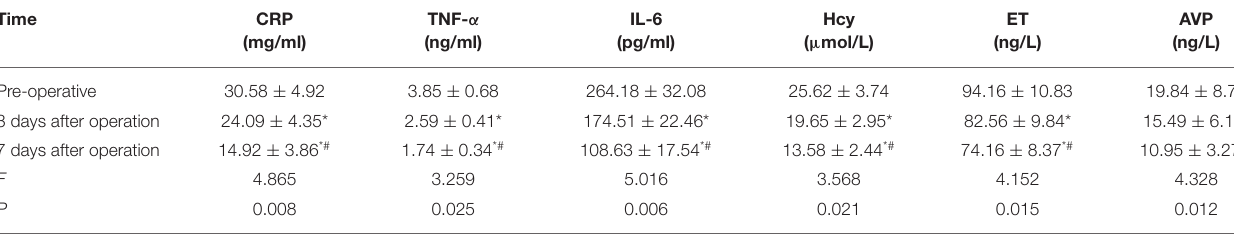
TABLE 3 | Changes in serum inflammatory factors and vasoactive factors in all patients before and after treatment ( n , x ± s).